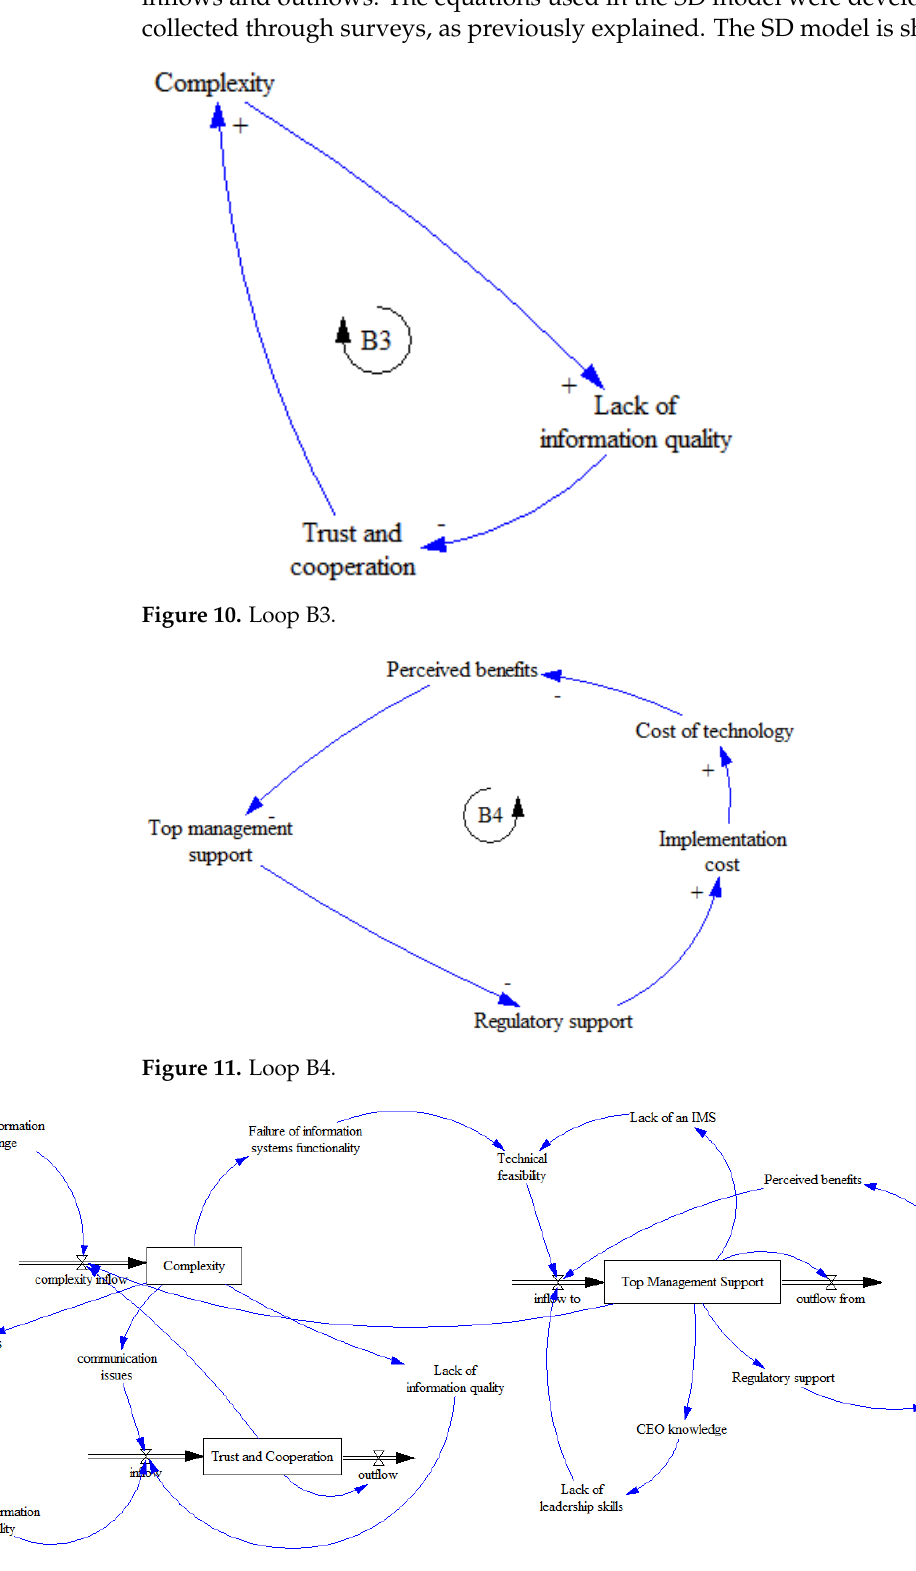
Figure 12. System dynamics model for managing information complexity.